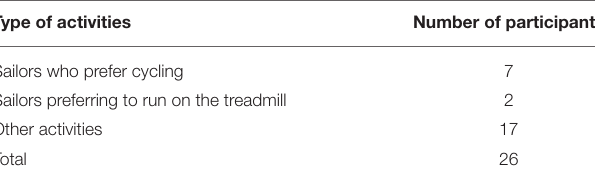
TABLE 5 | Types of activities chosen and number of participants. Type of